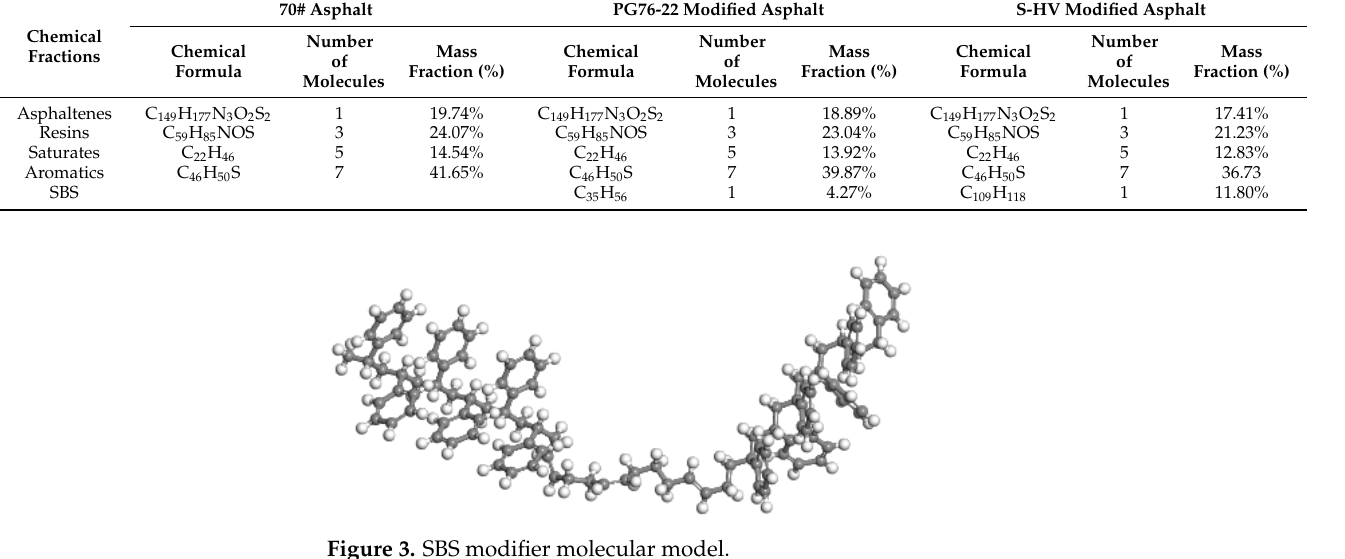
Table 1. Detailed composition of three asphalt materials.